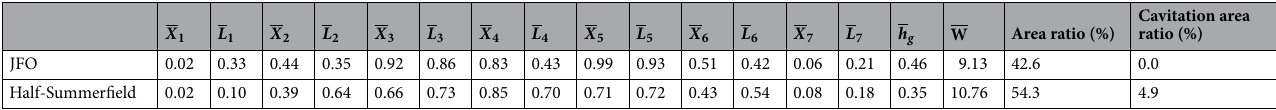
Table 5. Dimensionless design variable and the corresponding cavitation area and W for the JFO and Half- Sommerfield conditions (unrestricted).